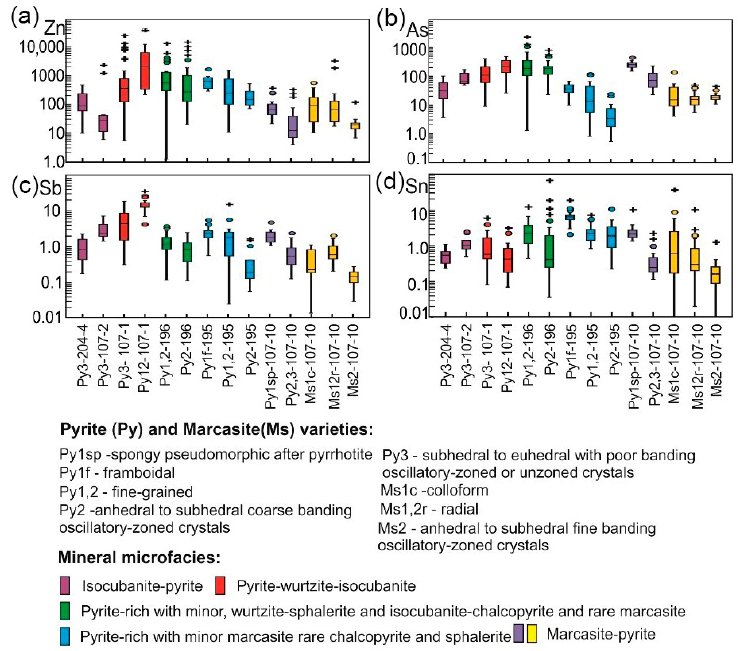
Figure 11. Whisker-and-box plots for the moderate temperature association of elements Zn (a) , As (b) , Sb (c) , and Sn (d) in pyrite and marcasite ranged in isocubanite-rich to pyrite and marcasite-pyrite rich microfacies. The box encloses the interquartile range with median displayed as a line. The vertical lines extending outside of the box mark the minimum and maximum element concentrations encountered. Outliers are plotted as single points.